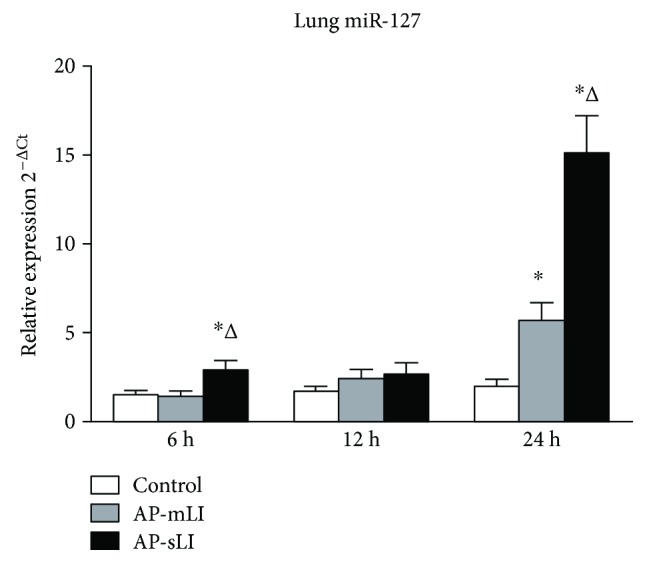
The relative expression of miR-127 in the lung tissues of rats. The level of miR-127 was expressed as 2−ΔCt (ΔCt = CtmiR-127 − CtU6 snRNA) using REST 2009 software (Qiagen Inc.). ∗P < 0.05 versus control group; ΔP < 0.05 versus AP-mLI group.